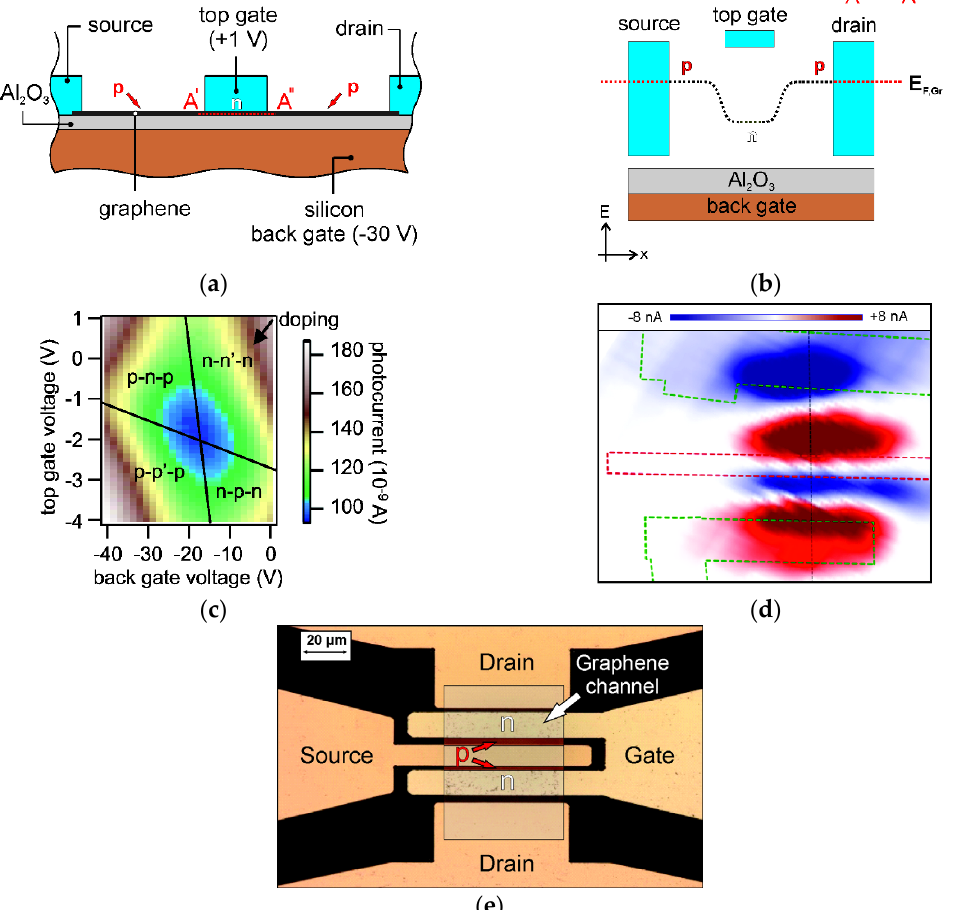
Figure 1. ( a ) Schematic of a top- and back-gate tunable graphene phototransistor; ( b ) Schematic of the band structure of a symmetric phototransistor with a top and a back gate; ( c ) Drain current (color scale) as a function of the back and top gate voltages. The black lines indicate the location of the charge neutrality (Dirac) point of the global (back gated) and local (top gated) device. The phototransistor can be operated in four distinct regions ( i.e. , p-n-p etc. ); ( d ) Photocurrent map of a lateral phototransistor. The photocurrent is highest at the location of p-n junctions, i.e. , next to the metal contacts and the top gate region (modified from [34]); ( e ) Optical micrograph of a graphene phototransistor. Examples for p and n regions are indicated.